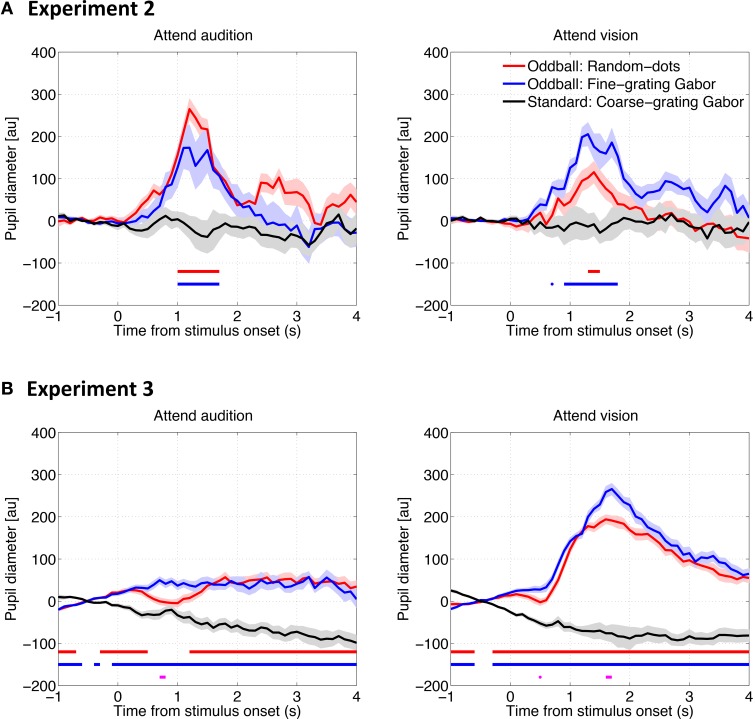
Pupil diameter change as a function of time relative to the visual stimulus onset in Experiment 2 (A) and Experiment 3 (B). The solid lines represent the median of the pupil diameter derived from all trials for all participants as a function of time relative to the visual stimulus onset. The shadows represent the standard error derived from a bootstrapping procedure (resampling n = 1500). The horizontal red and blue lines represent statistical differences between the baseline (i.e., the response to the standard coarse-grating Gabor patch) and the Random-dots noise disk and fine-grating Gabor oddballs, respectively. The horizontal magenta line represents the difference between the two types of oddballs (bootstrapping, with the Bonferroni correction).